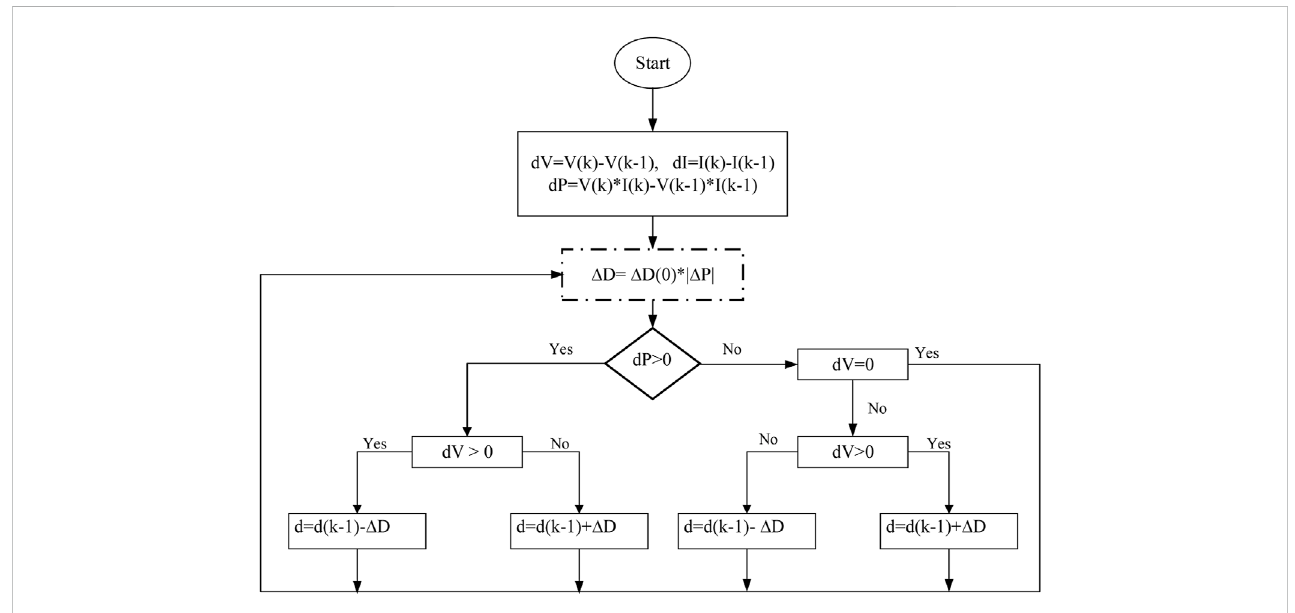
FIGURE 3 Flowchart of the modi fi ed VSSP&O MPPT technique.